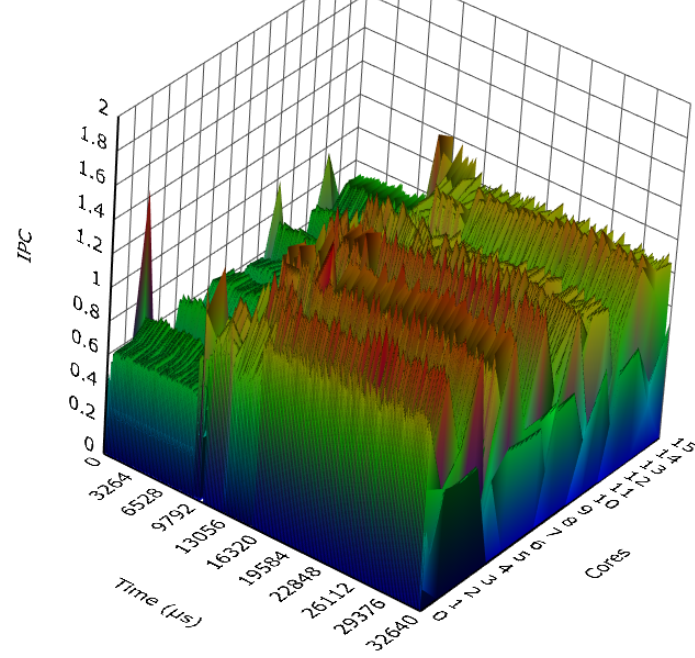
Figure 7. Illustration of cores utilization when using task